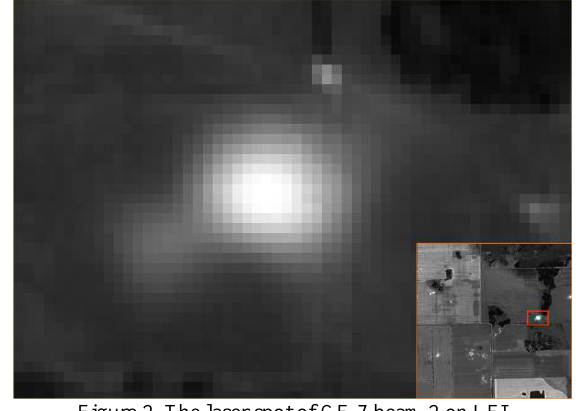
Figure 2. The laser spot of GF-7 beam 2 on LFI The grayscale weighting method can be used to extract the centroid of GF-7 laser spot, which accurately determine the image coordinate of the laser centroid. The grayscale weighting formula is shown below.